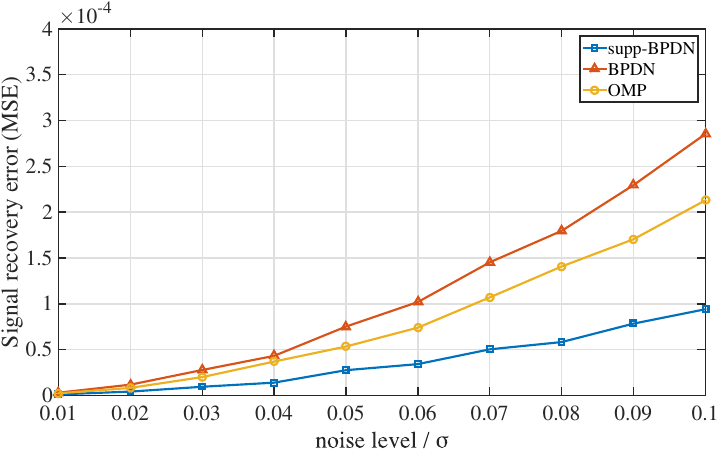
Figure 4. Signal recovery errors with respect to noise level among supp-BPDN, BPDN, and OMP algorithms.